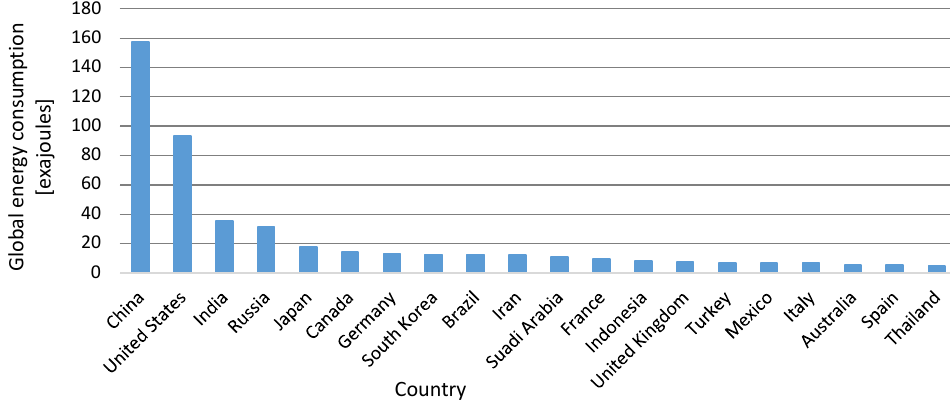
Figure 3. Global primary energy consumption in 2021 by country [26].